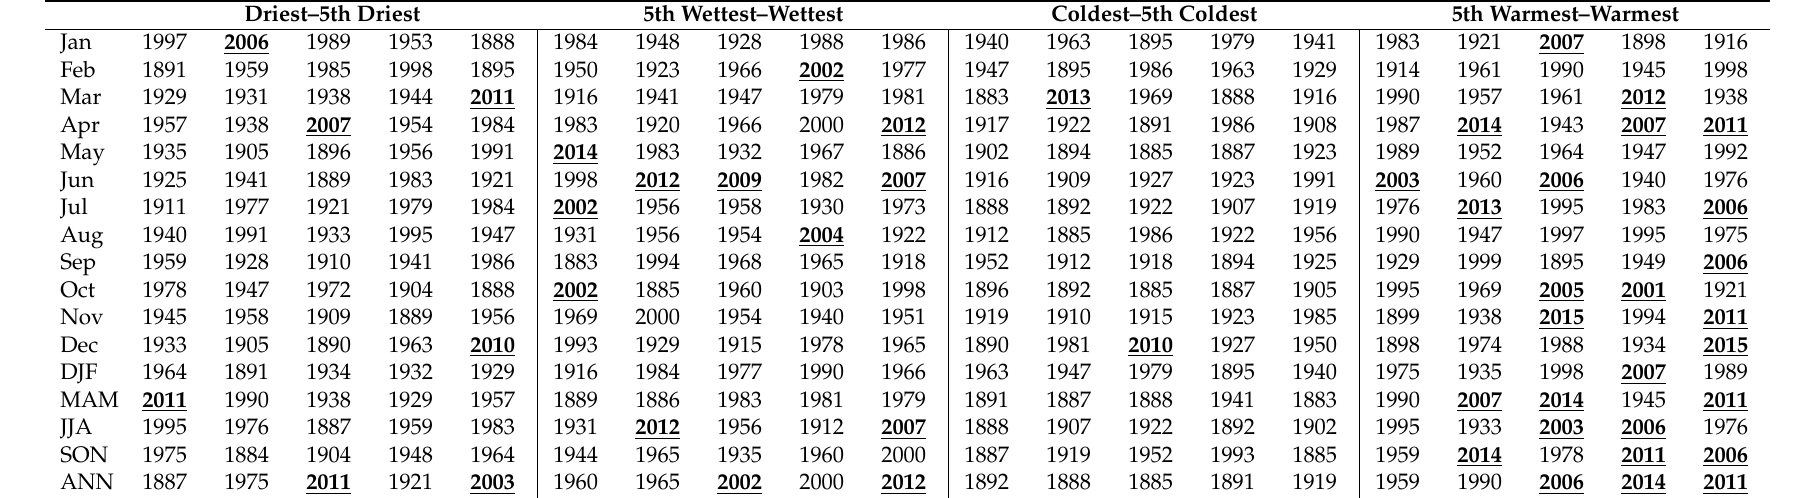
Table 4. The five-coldest/warmest and driest/wettest months, seasons and years based on mean temperature and precipitation data. Years since 2001 are highlighted to indicate “recent” (post-20th century)